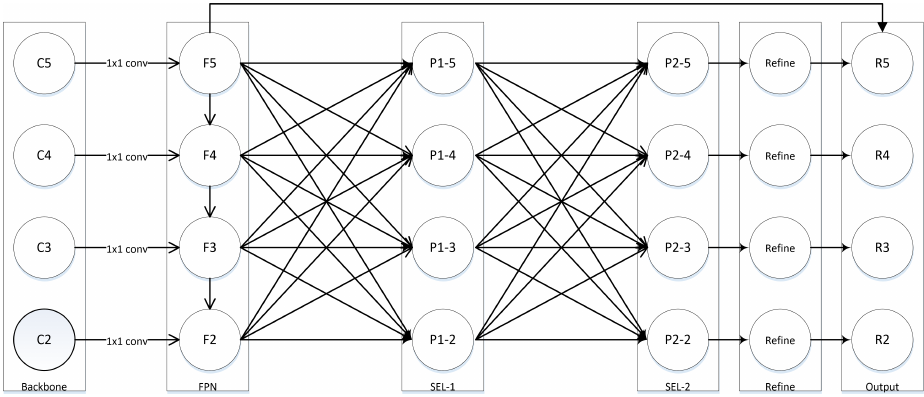
Figure 4. Pipeline of SEFPN. The whole pipeline is constructed by FPN, full connected layer, and a refine module. FPN acts as a basic module to output features. The full connected layer acts as a module to fuse all scales features. The last module is used to make the feature coarse or